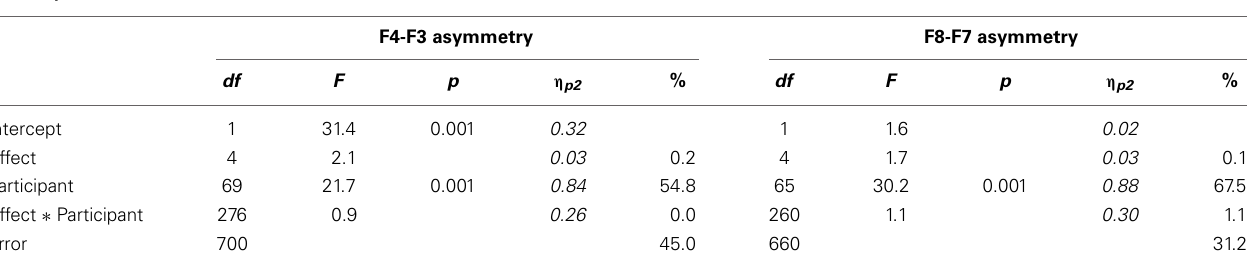
Table 2 | Results of mixed model ANOVAs of F4-F3 and F8-F7 state asymmetries. F4-F3 asymmetry F8-F7 asymmetry